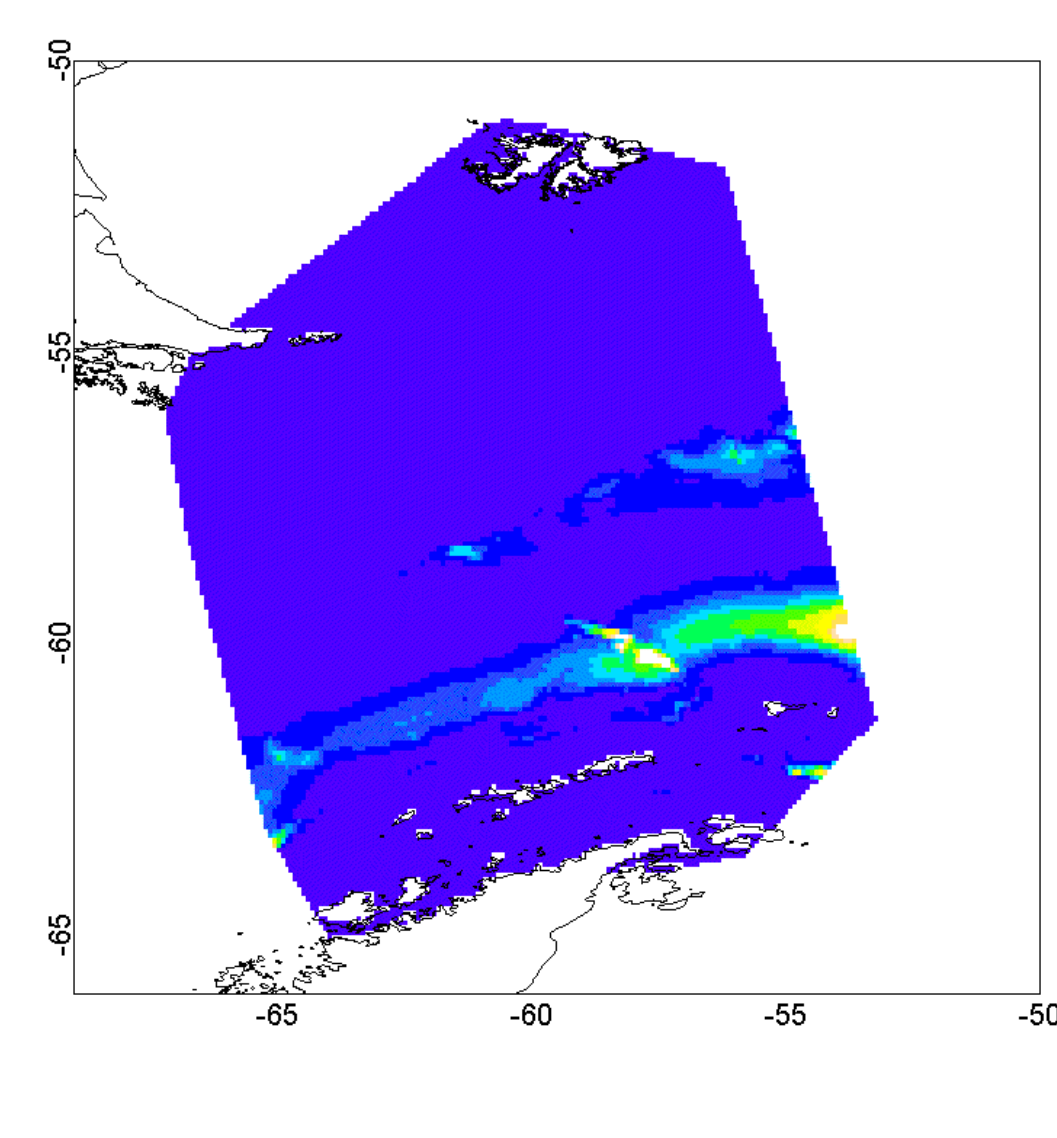
Fig. 5. An animation showing variation in predicted density of fin whales at each iteration. White patches within the regions of high density reflect grid squares predicted to have >0.22 fin whale schools/nm 2 . The longest axis of the prediction grid (from the southern tip of South America to the northern tip of the Antarctic Peninsula) is approximately 500 nm long. Note that the area predicted to have the highest density of fin whale schools showed more variability than was seen in humpback whales (Fig. 2), but was always predicted to lie in offshore waters, running parallel to the Antarctic